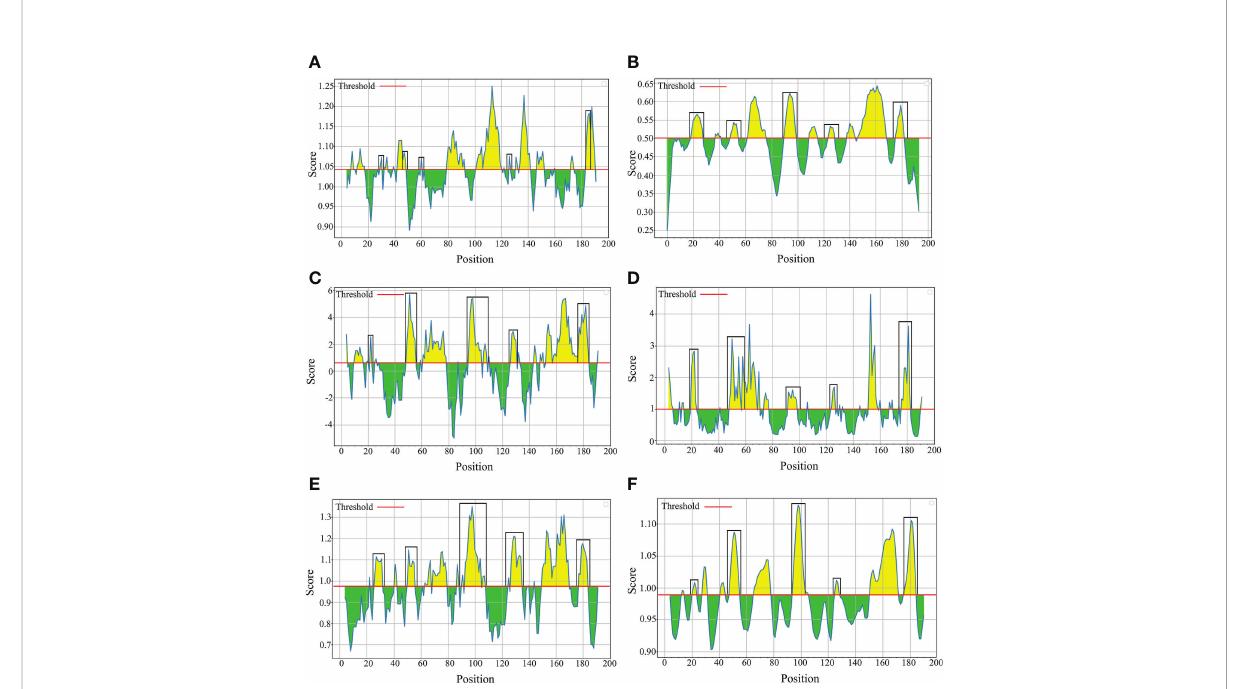
FIGURE 5 The physicochemical properties of B bovis sbp-2 protein were assessed based on Kolaskar & Tongaonkar antigenicity (A) , BepiPred linear epitope (B) , Parker hydrophilicity (C) , Emini surface accessibility (D) , Chou & Fasman Beta-turn (E) and Karplus & Schulz fl exibility prediction (F) .